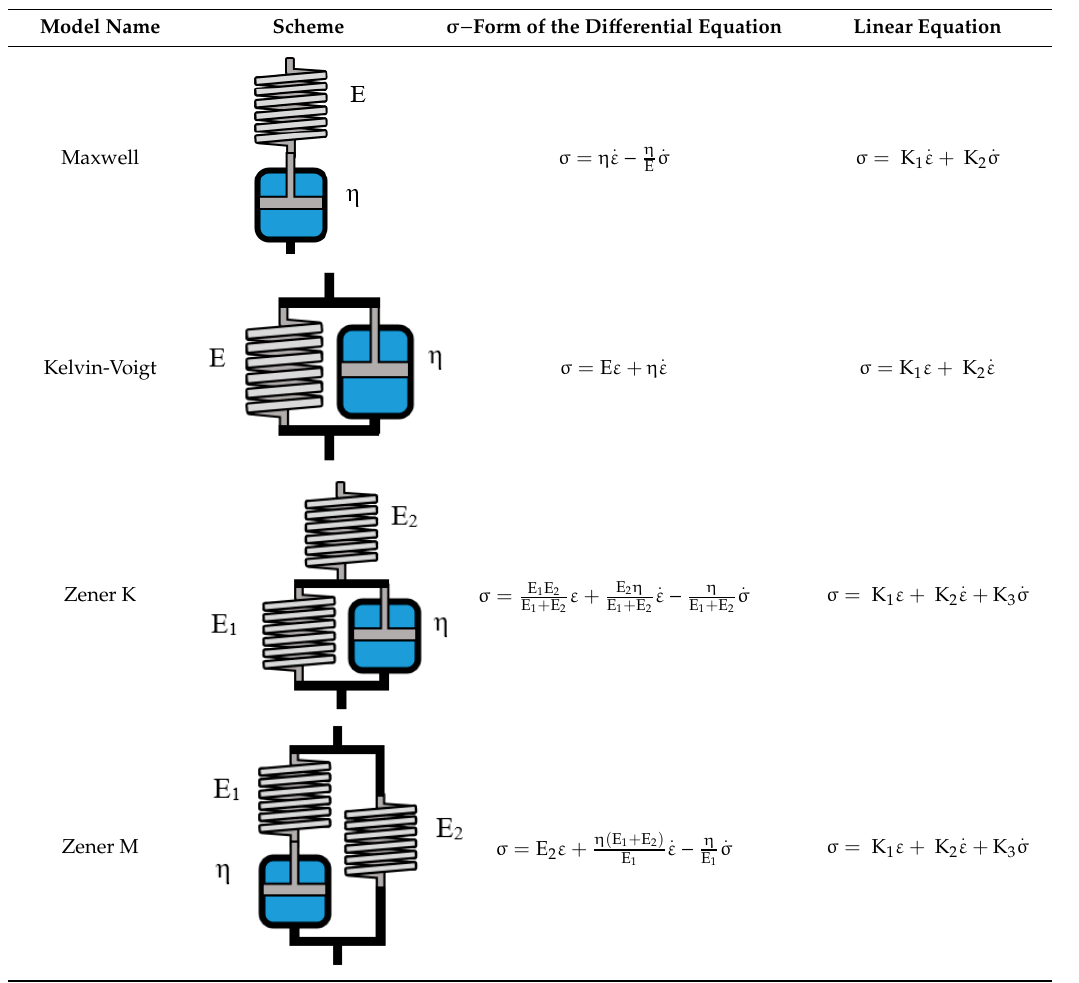
Table 2. Overview of rheological models with constitutive equations of first order differential equation type, having 2 or 3 main effects Ki.